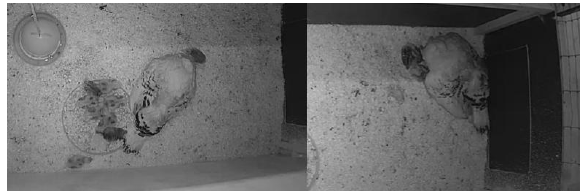
Figure 2. An example of chick-to-chick occlusion while feeding on the left and while sleeping on the right. ©TiHo Hannover be seen when all the animals group together for food or sleeping as depicted in Figure 2.